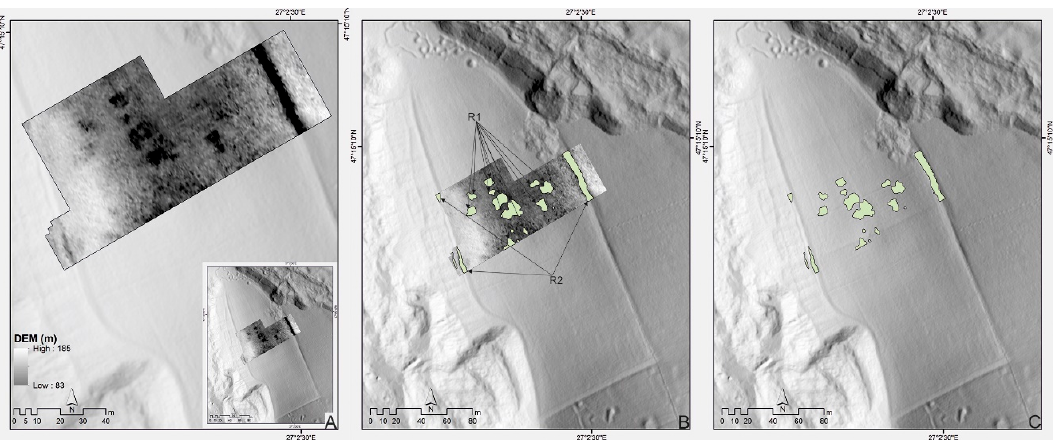
Figure 10. Interpreting the anomalies identified in soil electrical resistivity measurements: ( A ) High pass filtered earth resistivity data ( − 5 to +5 Ω · m) overlaid on the digital model from the ALS; ( B ) Identifying anomalies; ( C ) Distribution of anomalies within the study area.